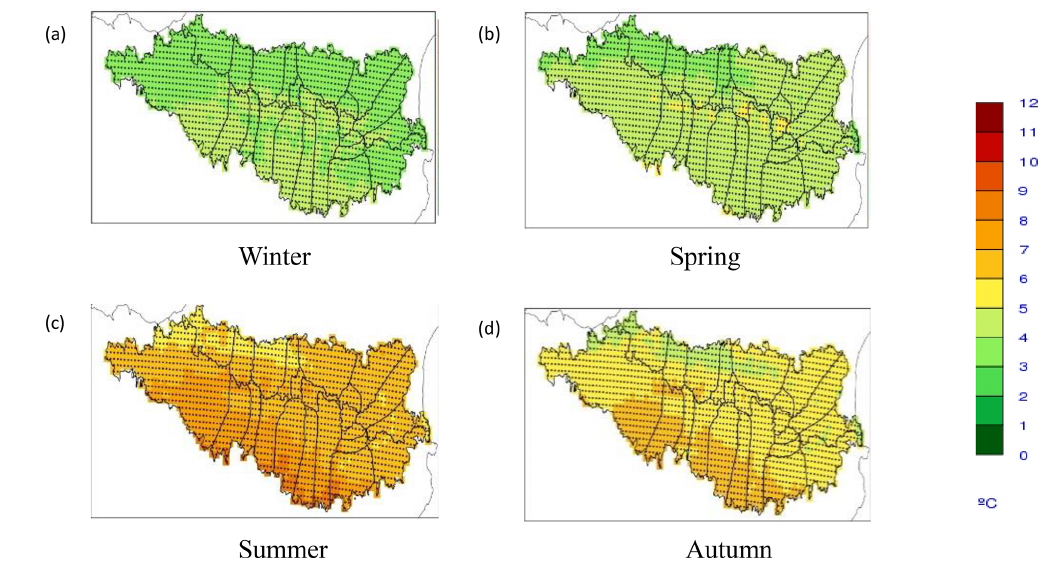
Figure 4. Maps of maximum temperature anomaly for different seasons (a–d) and for RCP8.5 scenario and 2090 horizon. Stippled area reflects major signal ( q 50 > (( q 83 − q 17 ) /